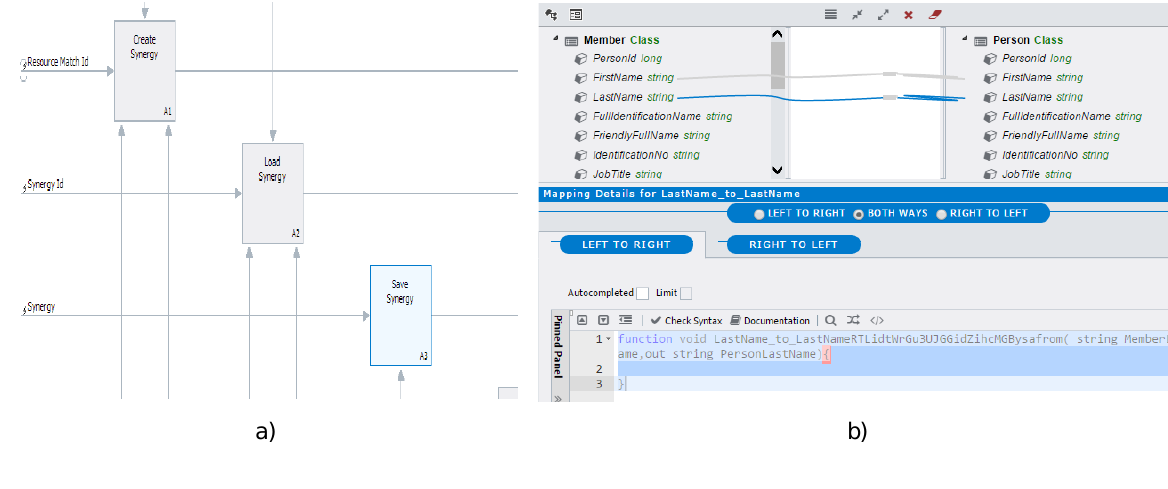
Figure 4. Example of differences – a) zAppDev IDEF0 does not exist in CDD, b) zAppDev data transformations correspond to context element calculation in